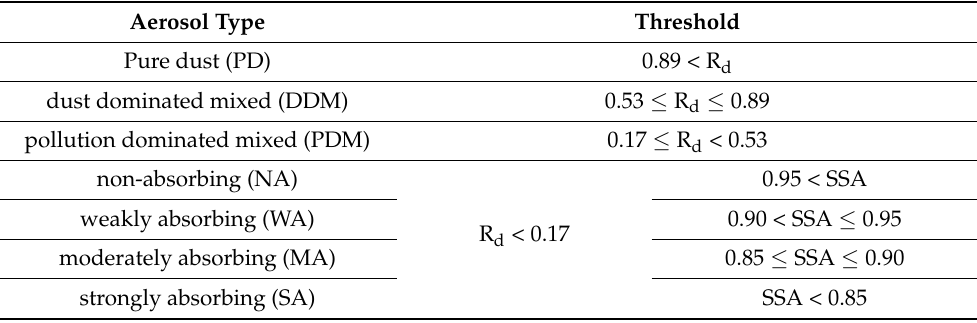
Table 2. Threshold values used in classifying aerosol types using AERONET measurement